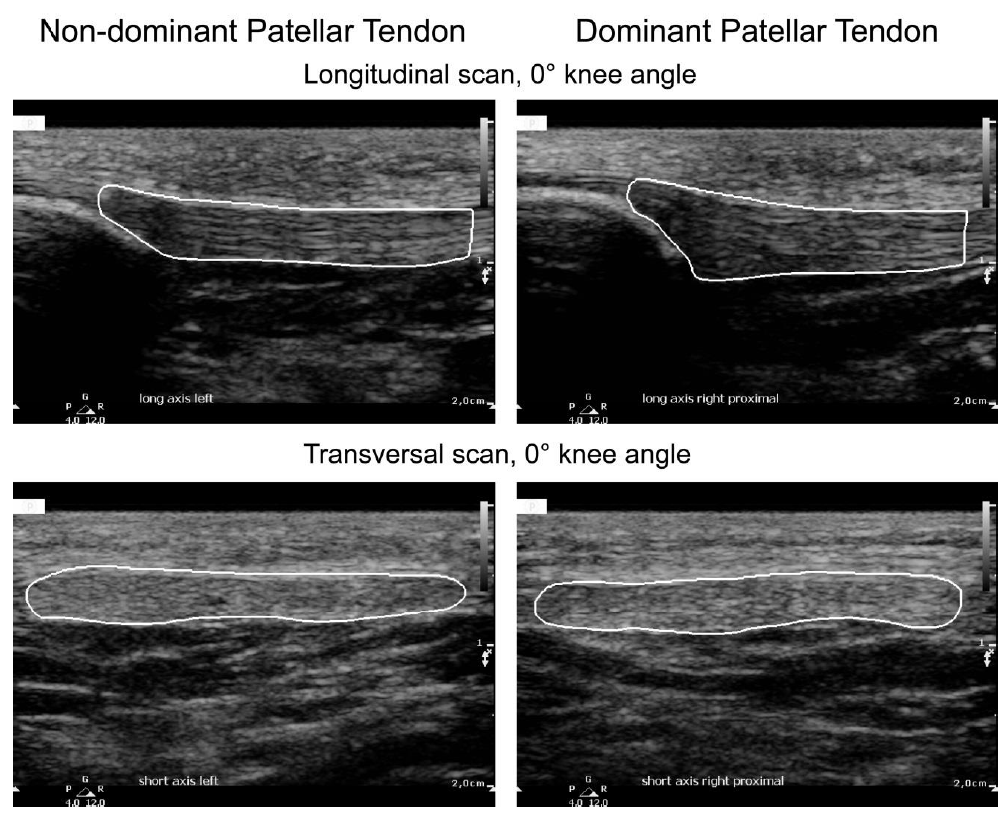
Figure 1. Representative patellar tendon images of one player displaying both the dominant and non-dominant side.